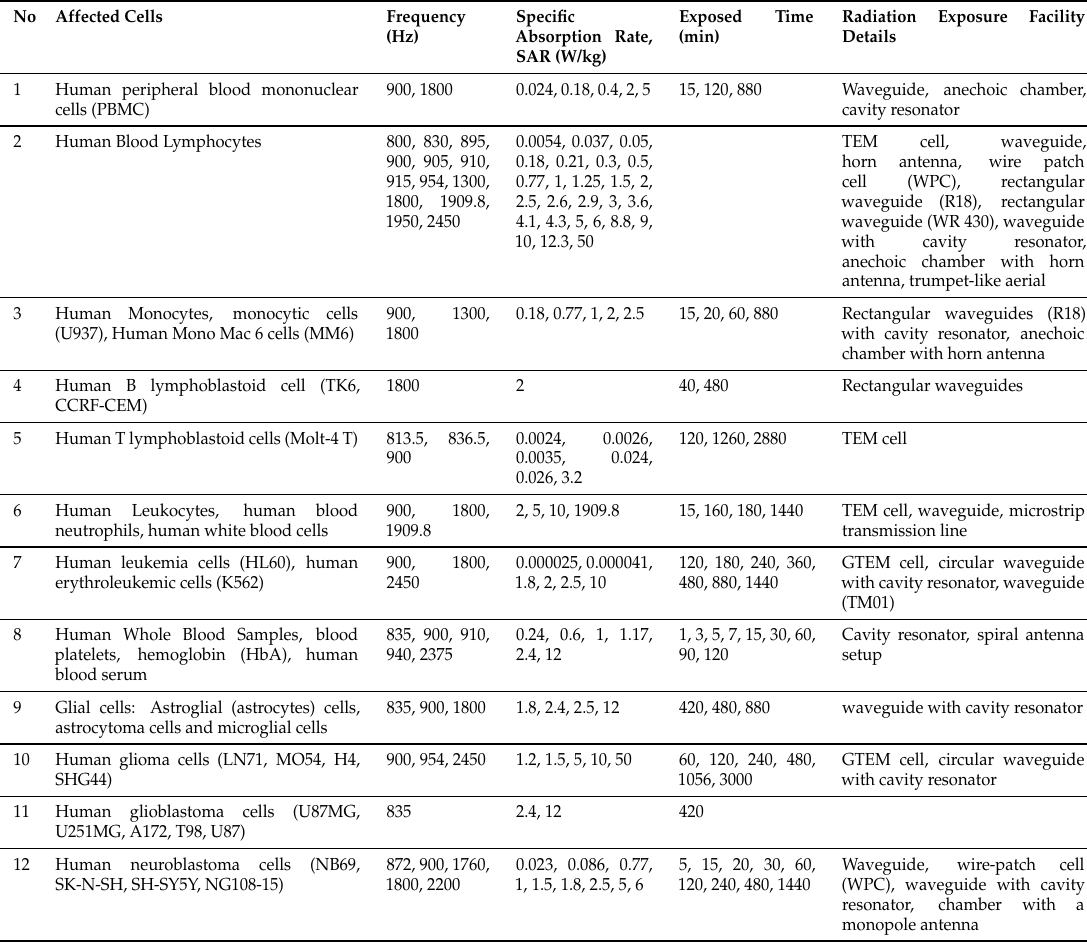
Table 3. An overview of the utilized laboratory experiments that provided positive association (cellular response—presence) between weak RF-EMF and